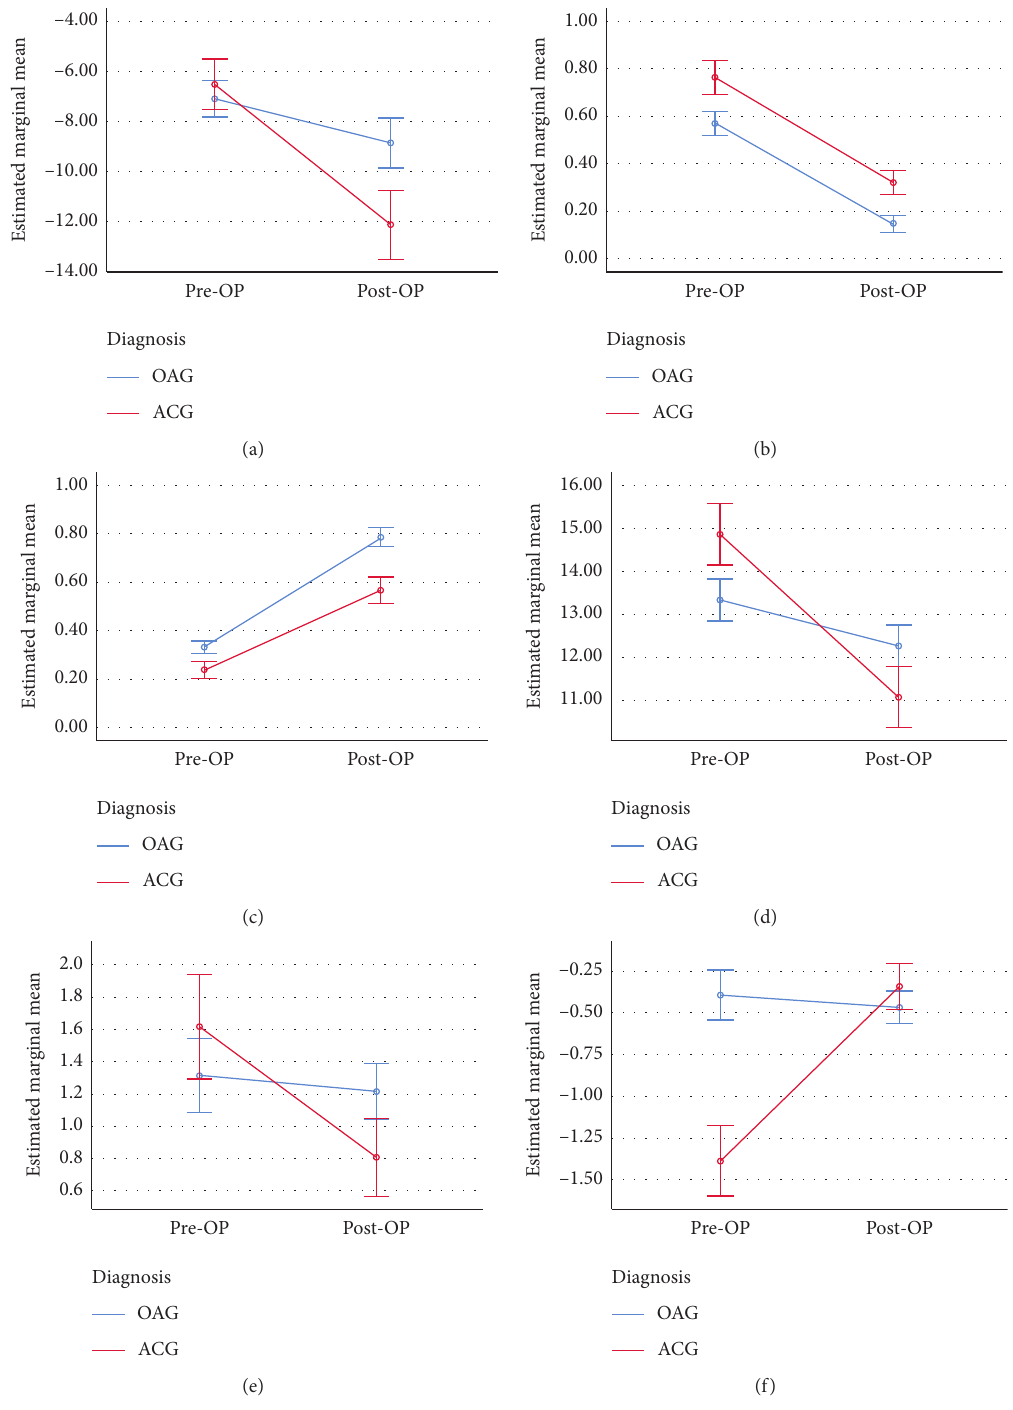
Figure 3: ANOVA group-time interaction effect on (a) MD, (b) logMAR, (c) Snellen VA, (d) IOP, (e) number of medications, and (f) MS slope in OAG and ACG. MD: mean deviation; logMAR: logarithm of the minimum angle of resolution; VA: visual acuity; IOP: intraocular pressure; MS: mean sensitivity; OAG: open-angle glaucoma; ACG: angle-closure